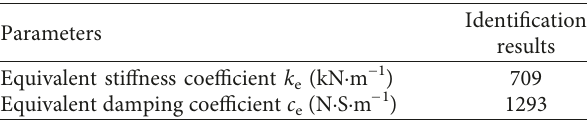
Table 4: Parameter identification